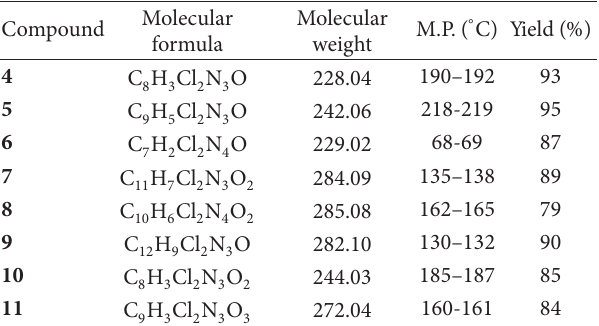
T 1: Physical data of compounds 4–11